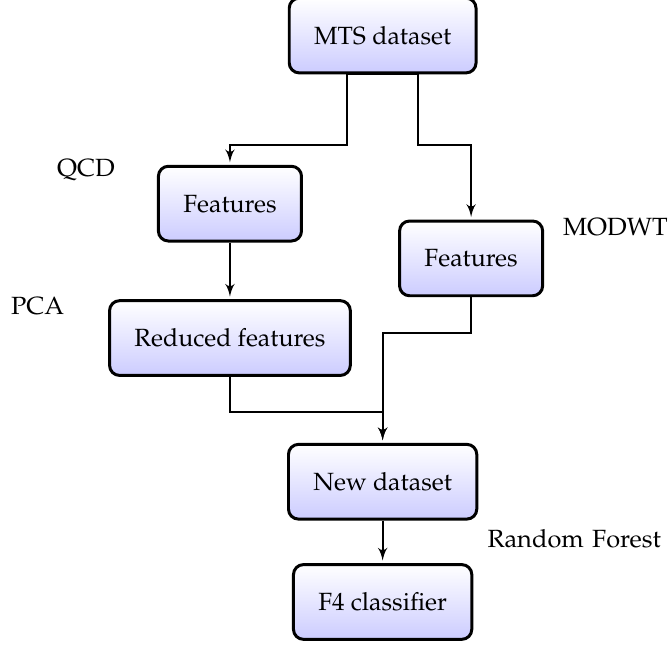
Figure 1. Flowchart of F4